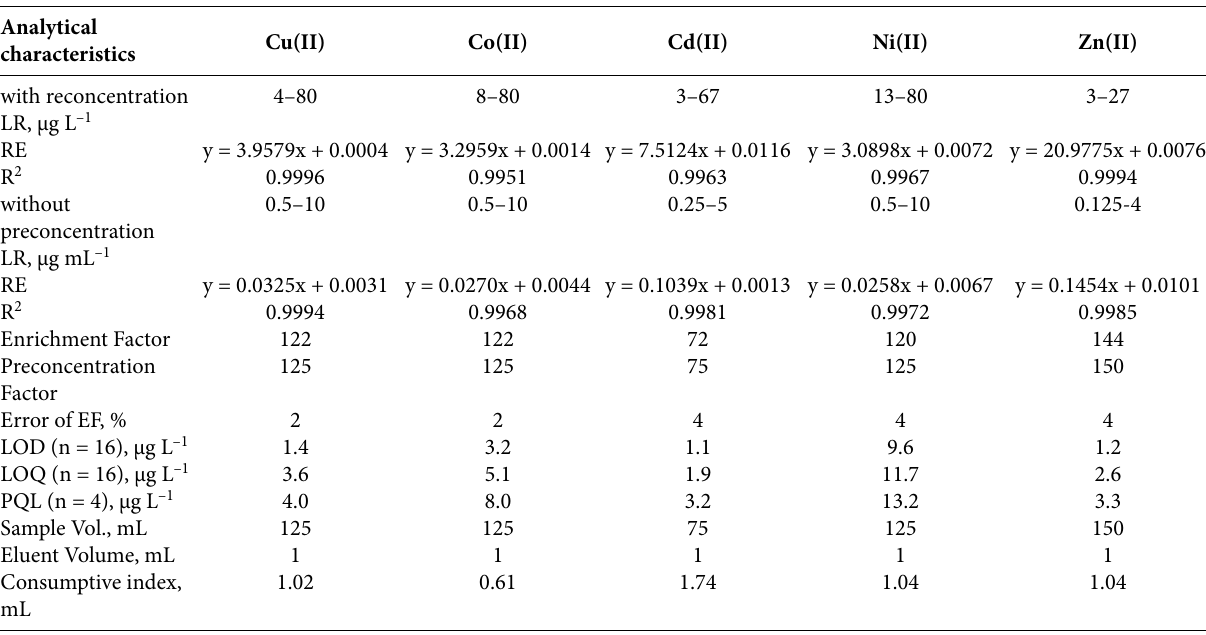
Table 4. Analytical characteristics of the proposed method at the optimum conditions.